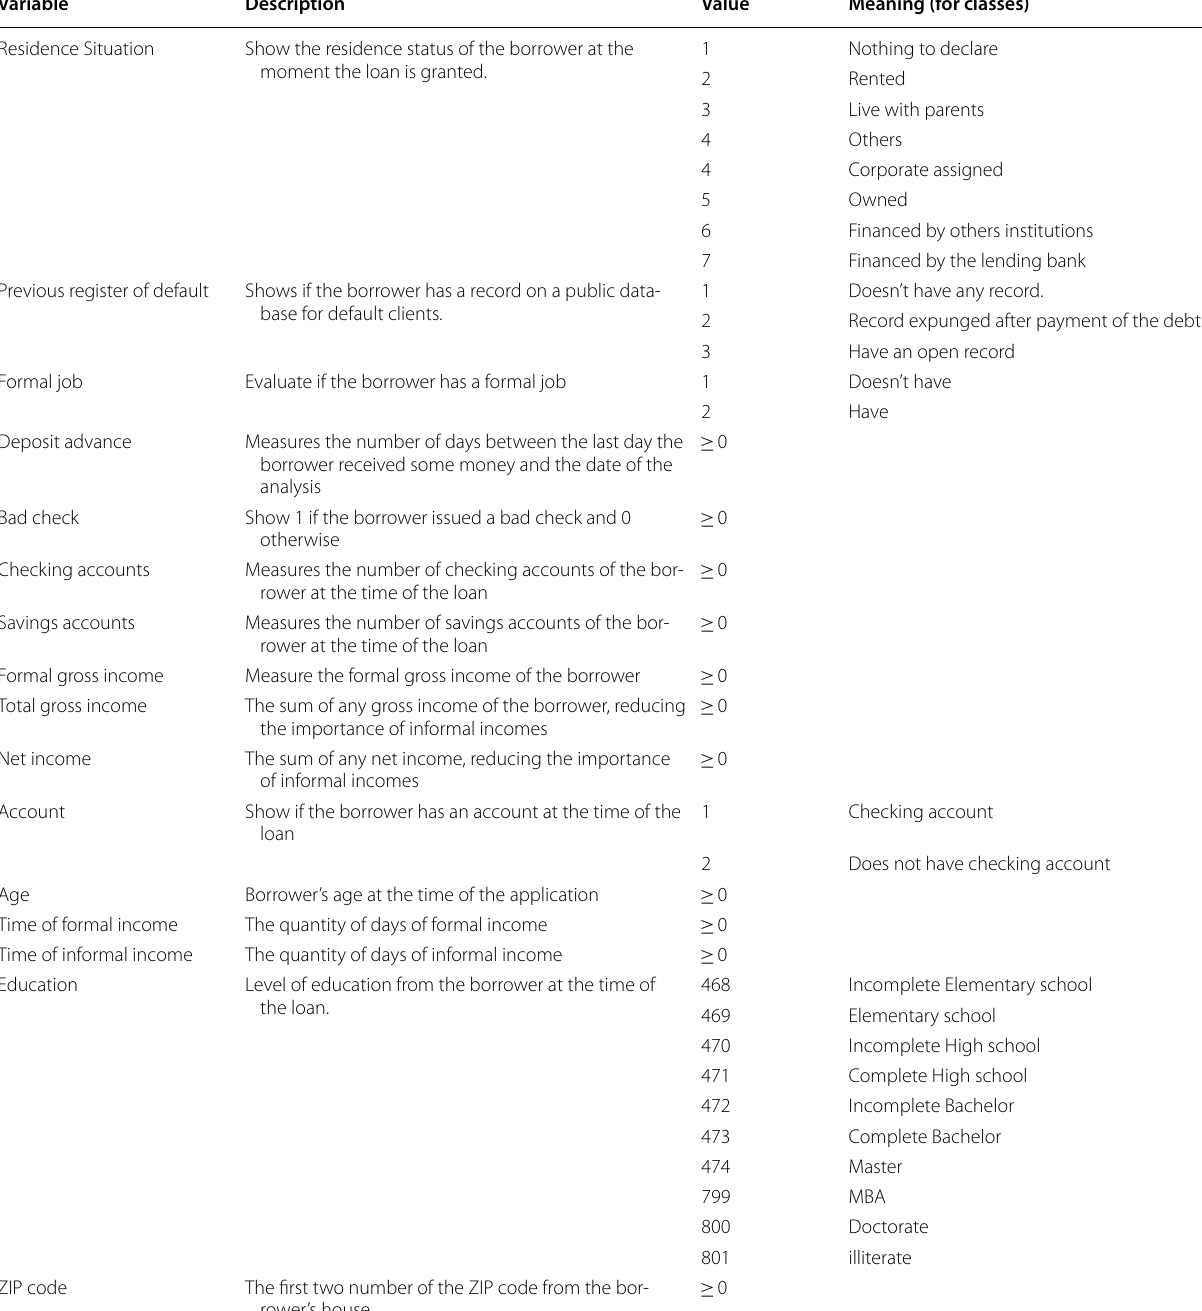
Table 1 Database and variables used in the analysis Variable Description Value Meaning (for classes) Residence Situation Show the residence status of the borrower at the 1 Nothing to declare moment the loan is granted.